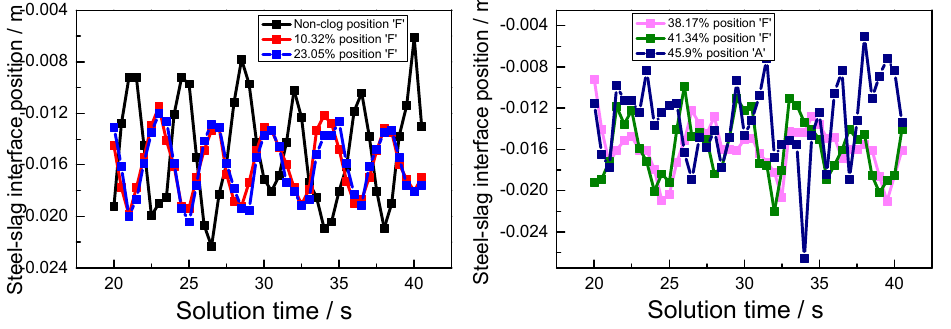
Figure 15. Steel–slag interface positions for original data in Table 3. Table 3. The indexes on steel–slag interface fluctuation.